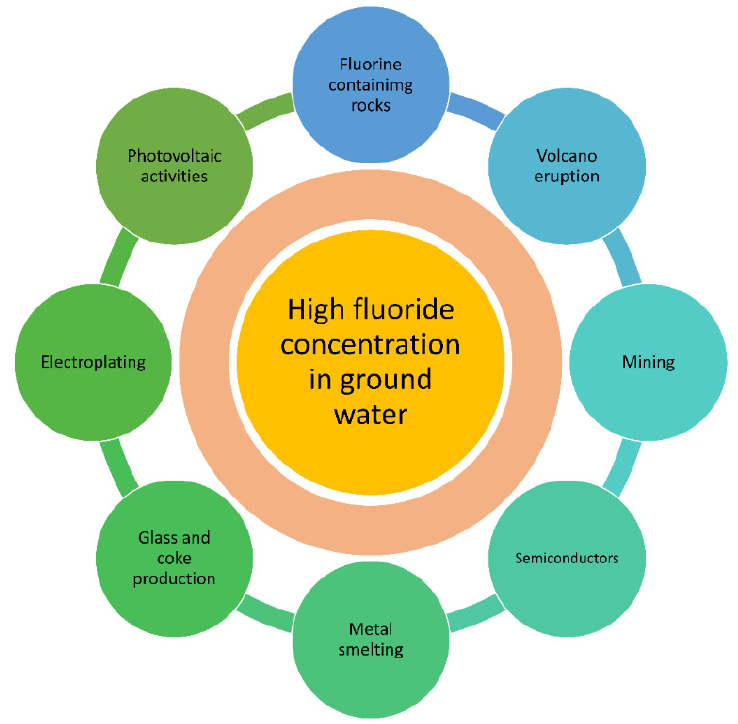
Figure 7. Source of fluoride entering to groundwater (adopted from